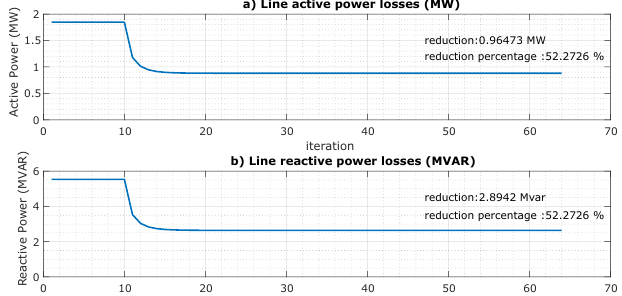
Figure 9. Illustration of algorithm evolution for reactive power compensation: ( a ) evolution of active power losses in catenary; ( b ) evolution of reactive power losses in